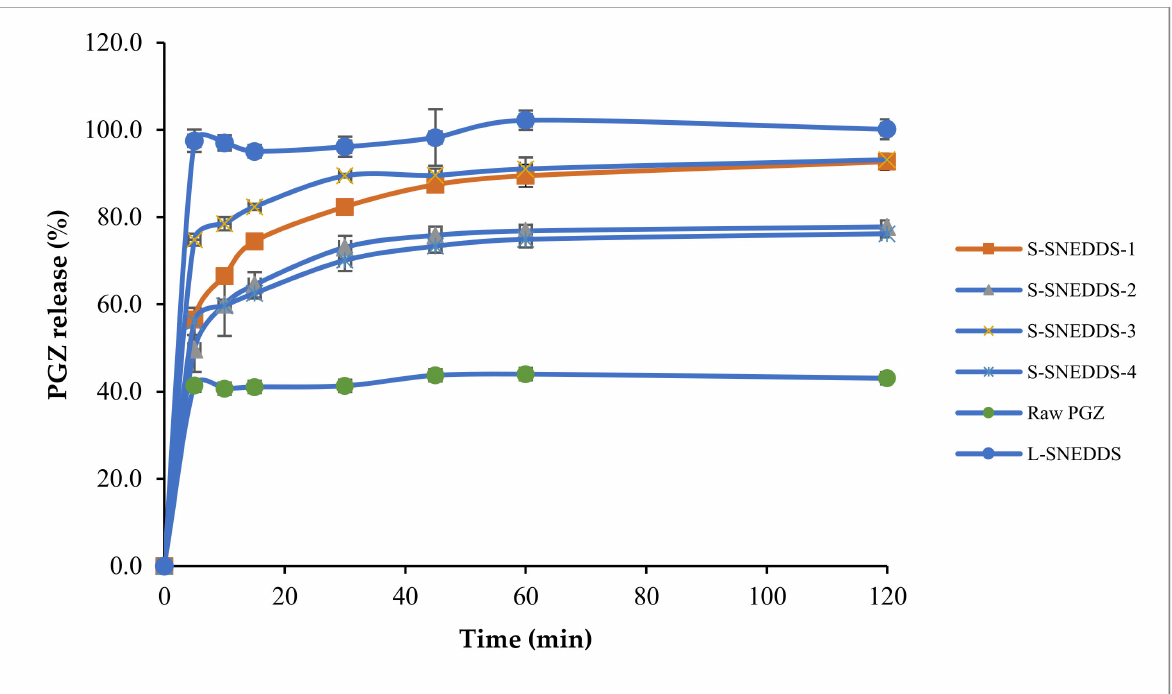
Figure 8. In vitro dissolution profile of PGZ from L-SNEDDS, S-SNEDDS (1 to 4) and raw drug. Abbreviations: S-SNEDDS, solidified self-nanoemulsifying drug delivery system; L-SNEDDS, liquid self-nanoemulsifying drug delivery system; PGZ, Pioglitazone